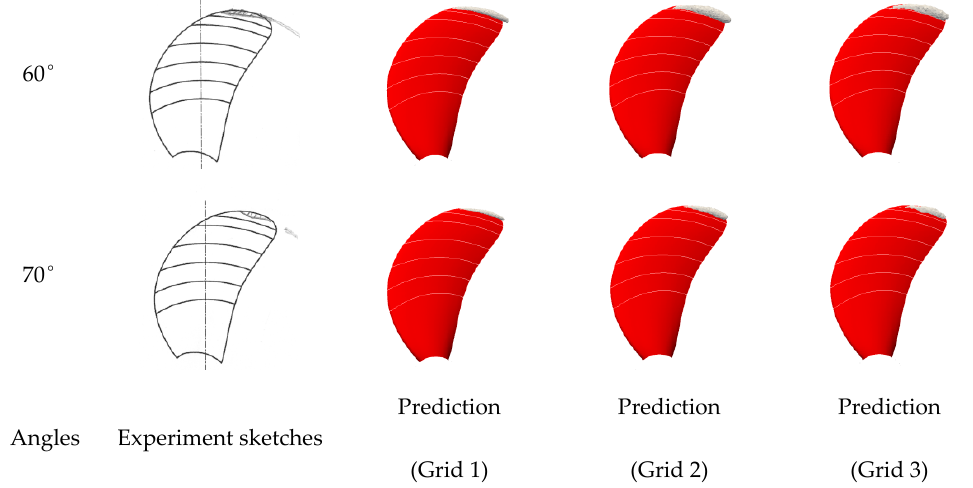
Figure 8. The predicted propeller cavitation shape compared with the benchmark test sketches.